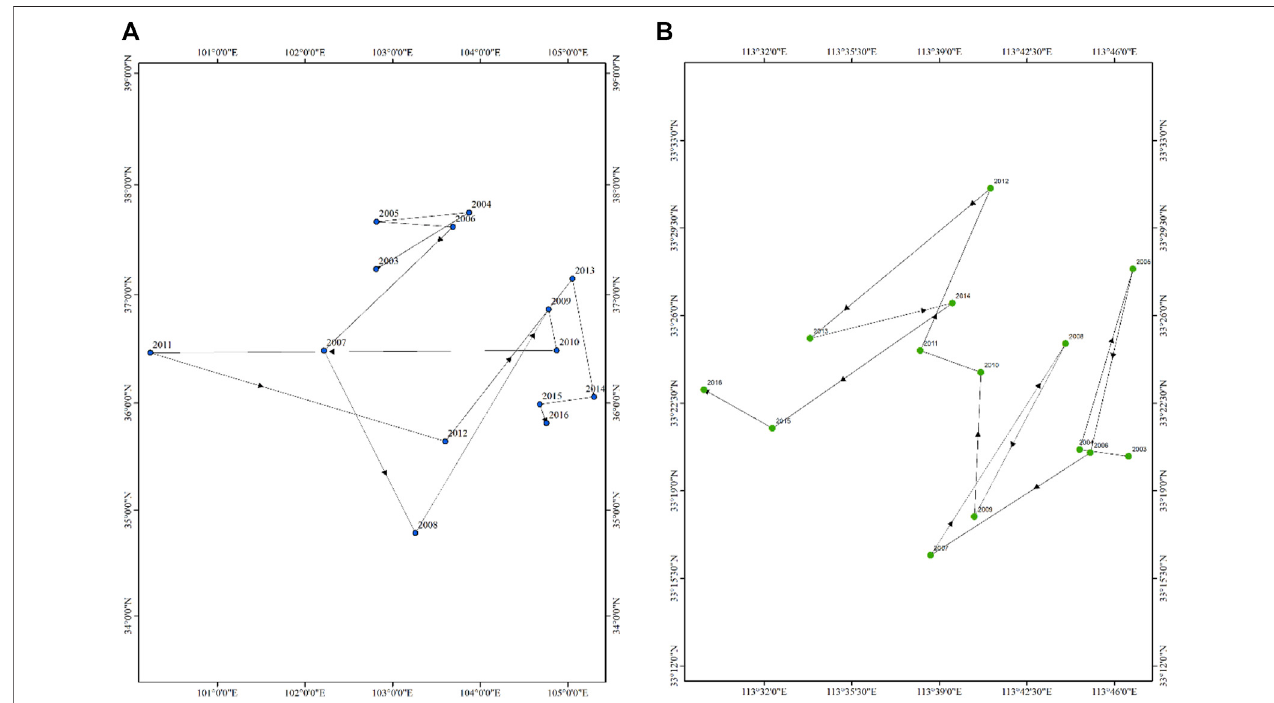
FIGURE 2 | (A) The Trajectory Plot of TWS ’ s center of gravity from 2003 to 2016 and (B) The Trajectory Plot of Cumulated NDVI ’ s center of gravity from 2003 to 2016.